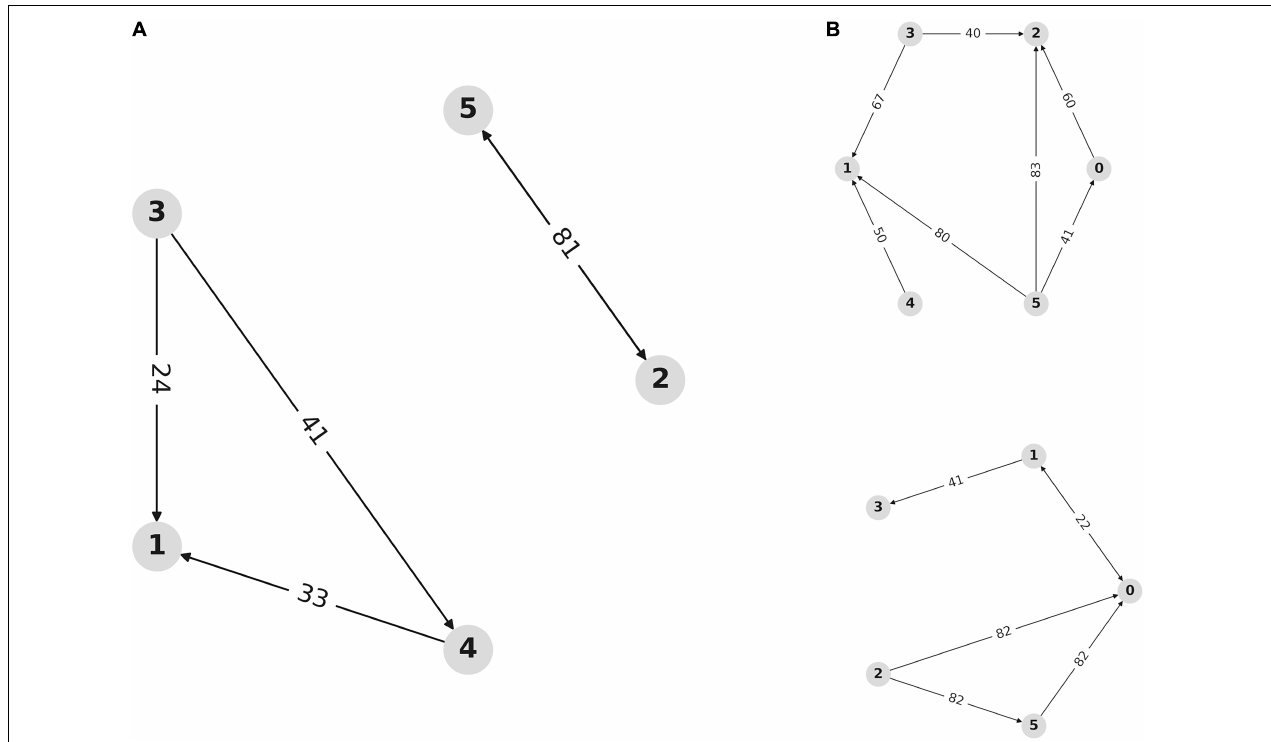
FIGURE 7 | Network dynamics are affected by outcome valence. (A) Network inferred from multivariate transfer entropy of independent activity sources for all trials. Nodes represent sources within the dACC network. Arrows represent the direction of information transfer between populations. Numbers indicate the lag (in samples at 2048 Hz) at which communication occurs between network nodes. This allows us to visualize dynamics within the dACC prediction network. Nodes 0, 1, and 2 are located in the left ACC with nodes 3, 4, and 5 on the right. Nodes 1, 3, and 4 consistently interact, as do nodes 2 and 5, but these subnetworks do not consistently communicate. (B) Network inference using multivariate transfer entropy of independent sources during correct and incorrect trials. Outcome valence results in an alteration in network dynamics through alterations in the temporal characteristics of information flow within the dACC prediction network. The top graph shows the network inferred from correct trials, while the bottom graph shows the network inferred from incorrect trials. The pattern of network communication differs based on outcome